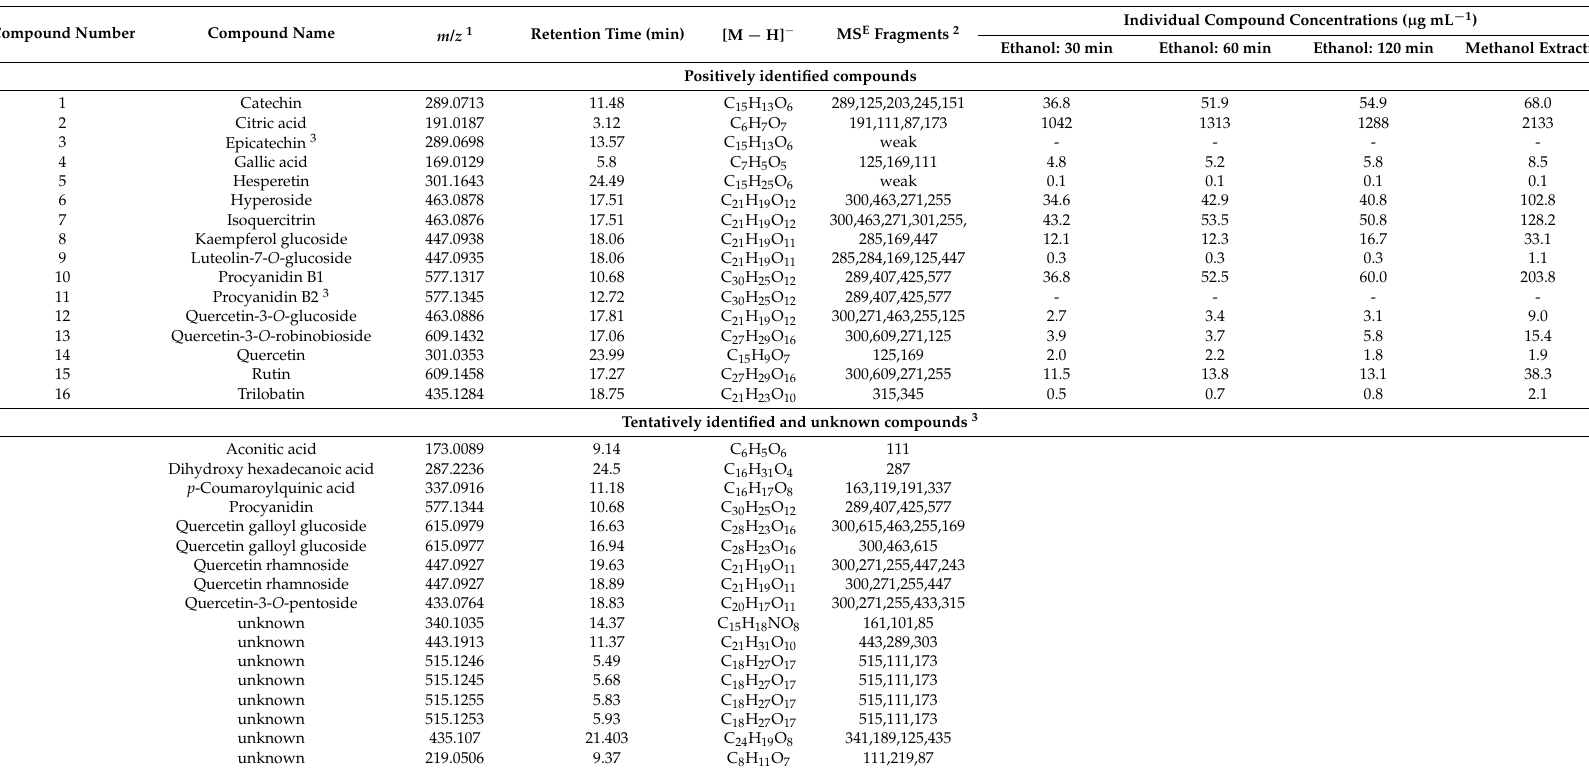
Table 1. LC-HRMS data obtained for the different extracts from Ximenia caffra , detailing compound identity and the time-dependent concentration for the ethanol